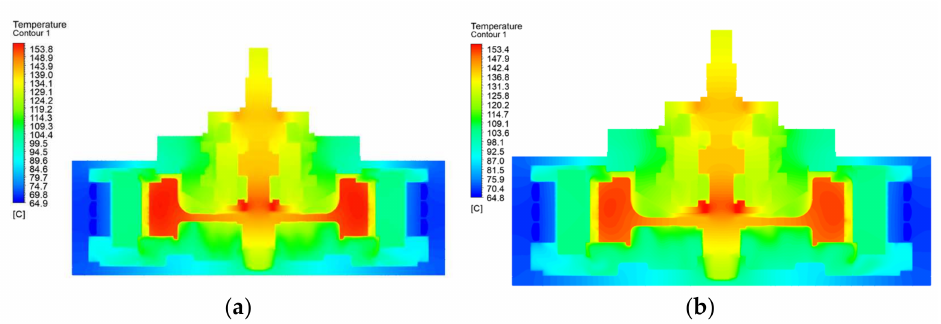
Figure 7. Comparison of average temperature of major parts of in-wheel motor with enhanced water channels.